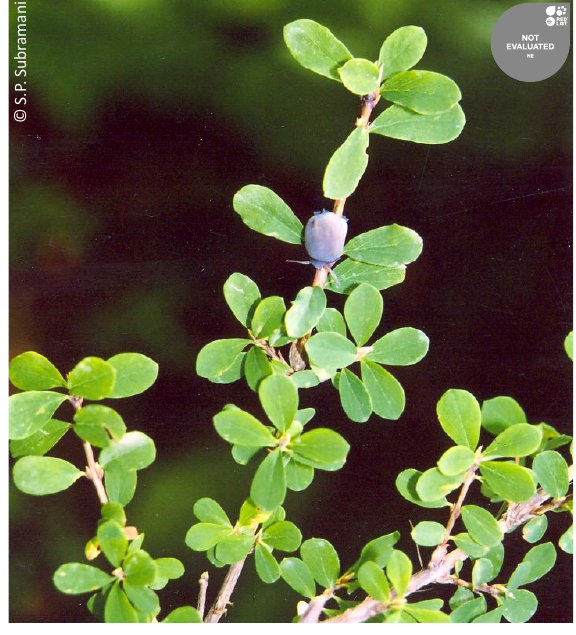
Image 9. Lonicera obovata Royle